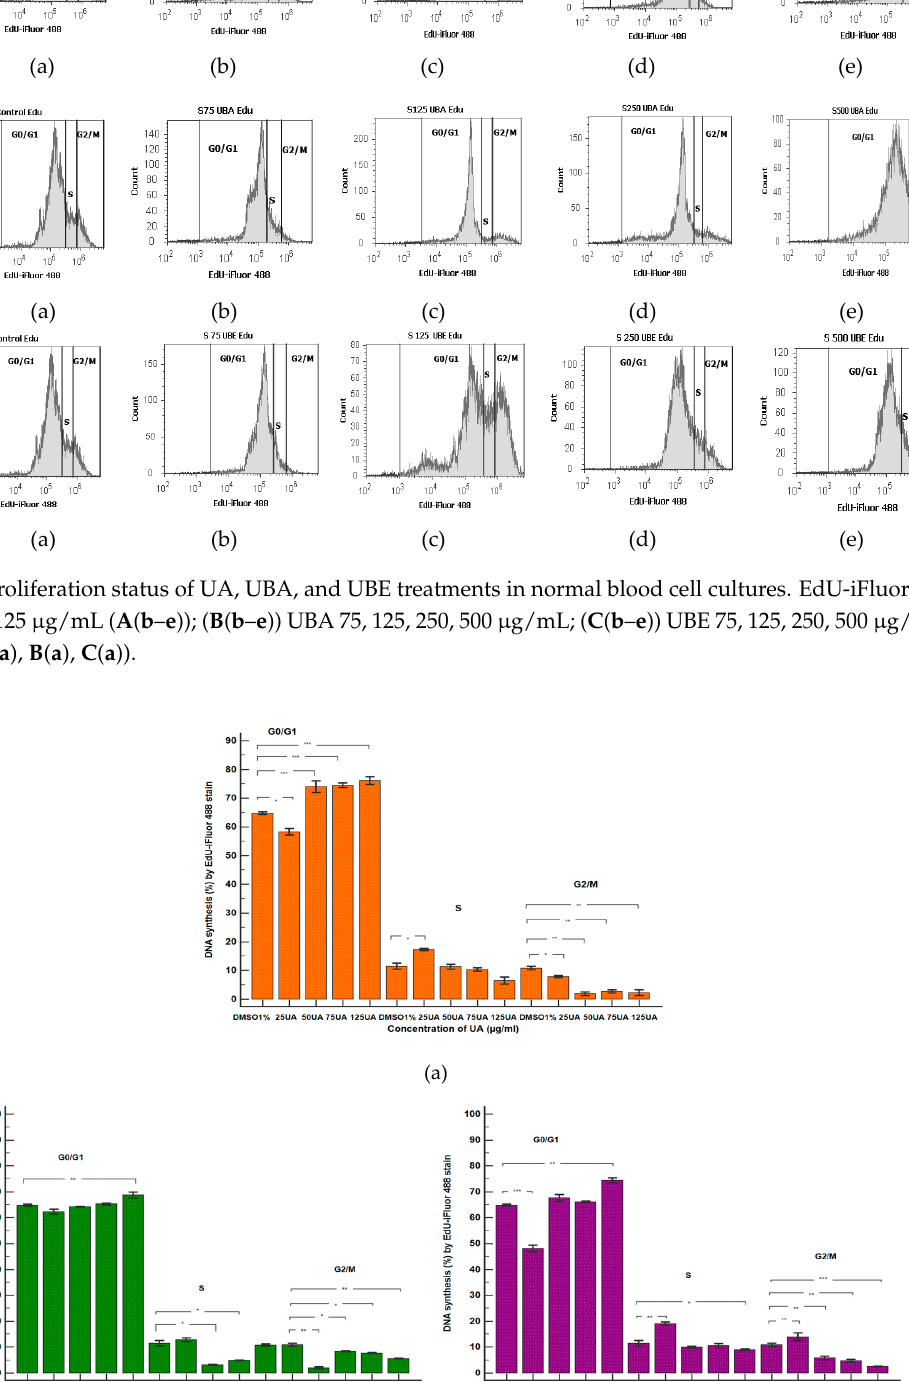
Figure 14. Statistical analysis of DNA synthesis: ( a ) UA; ( b ) UBA; ( c ) UBE. * p < 0.05, ** p < 0.01, and *** p ≤ 0.001 represent significant statistical differences between the control and samples made by paired samples t -test.